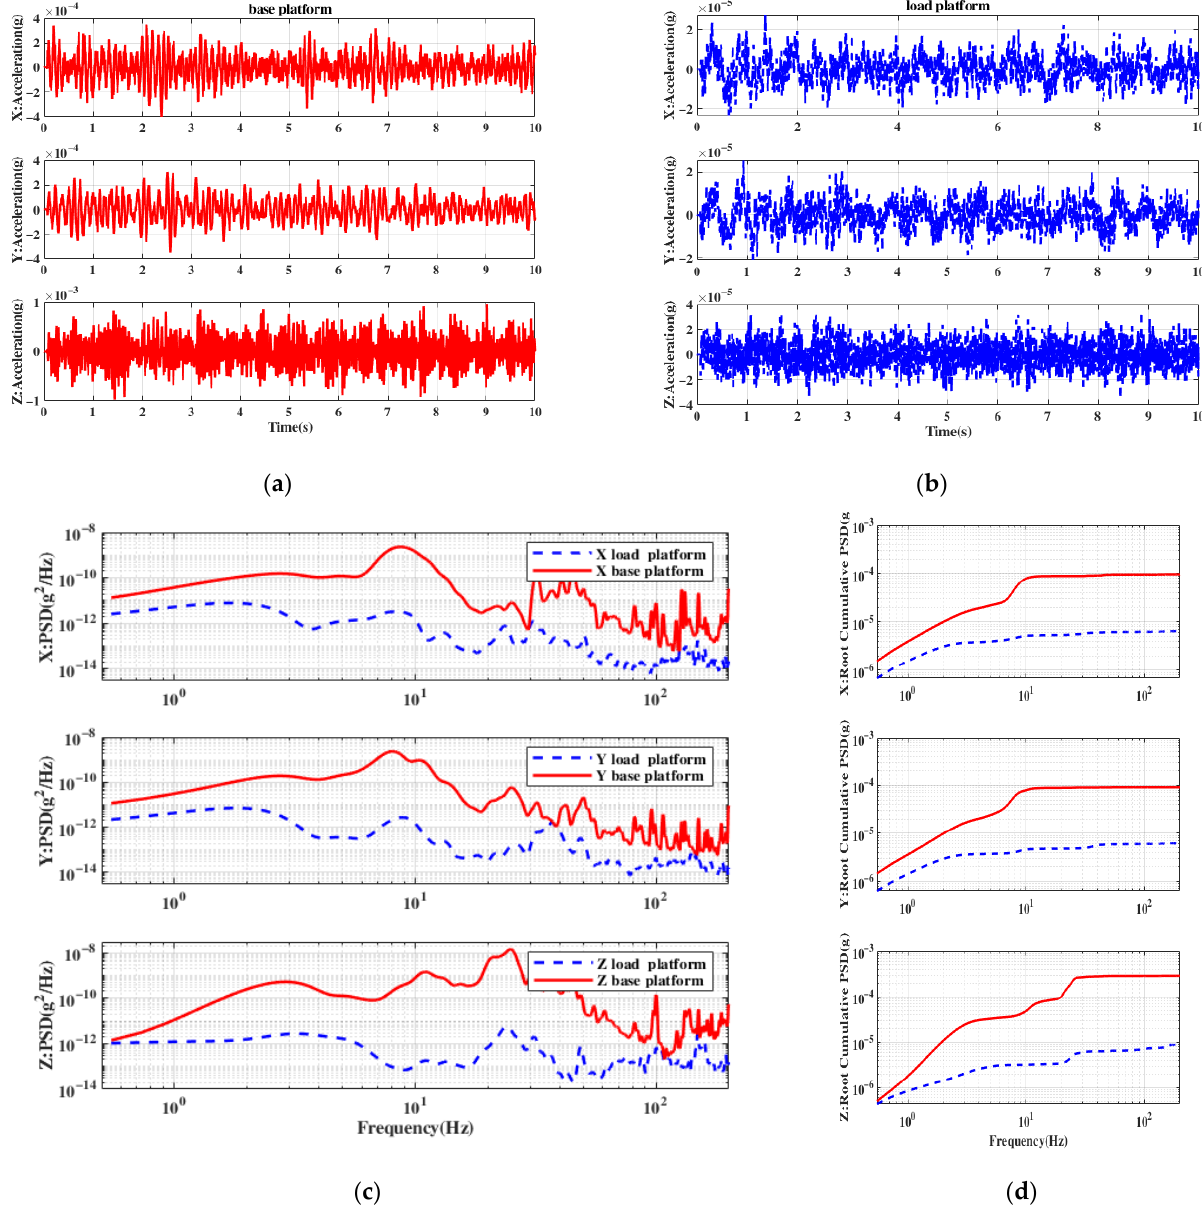
Figure 9. The performance of active vibration isolation with feedback control in three-axis. ( a ) Time domain acceleration of base platform; ( b ) Time domain acceleration of load platform; ( c ) Measured PSD; ( d ) Measured root cumulative PSD.